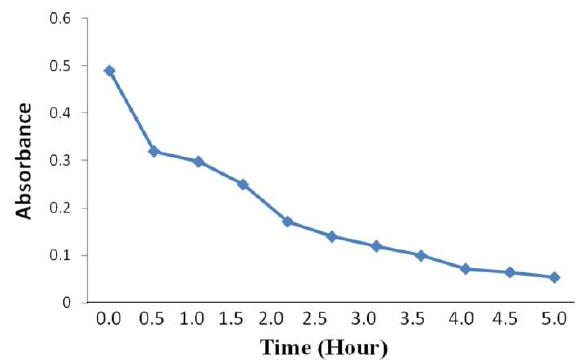
Figure 8. Bleaching of textile waste water by